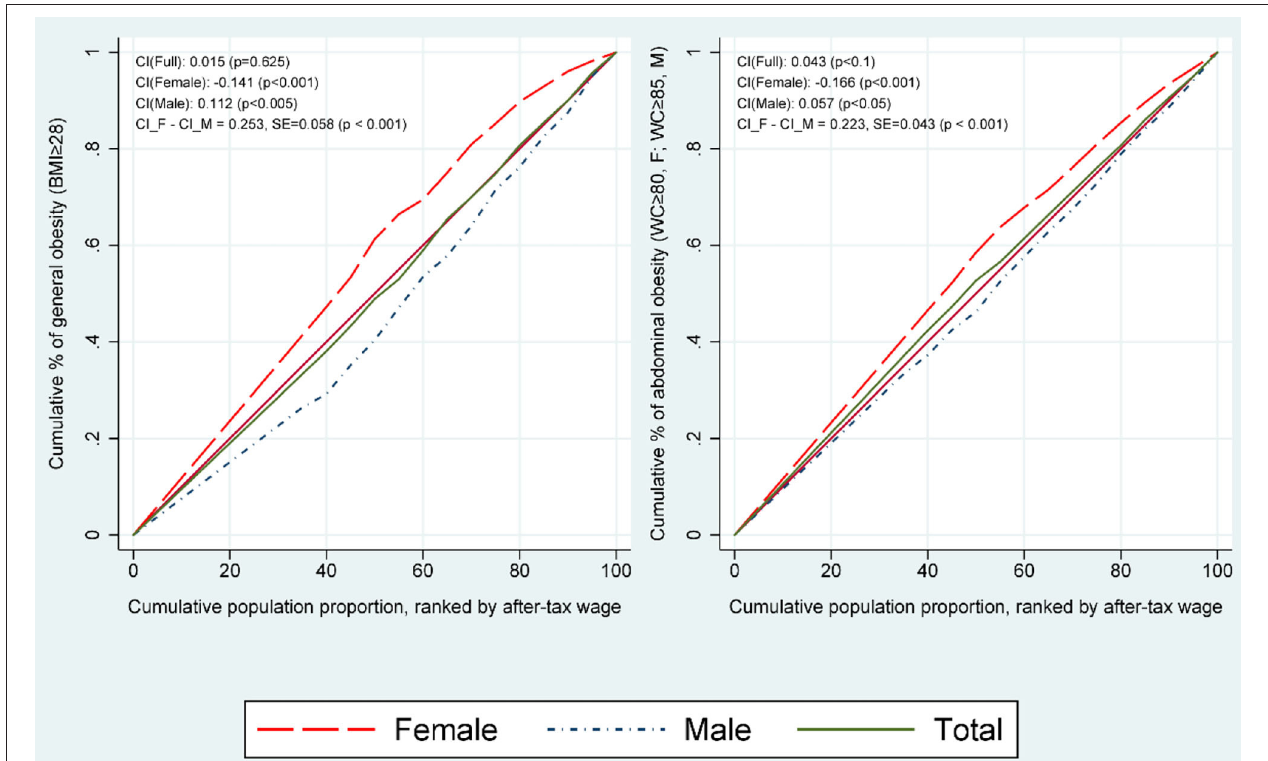
FIGURE 1 | Concentration curve for the probability of being general or abdominal obese (BMI ≥ 28; WC ≥ 80 for females or WC ≥ 85 for males) by total, female, and male works, China, 2016. X-axis represents the cumulative population proportion, ranked by individual annual after-tax wage; respondents are labor forces aged 16–65 in China and results are adjusted by sampling weights